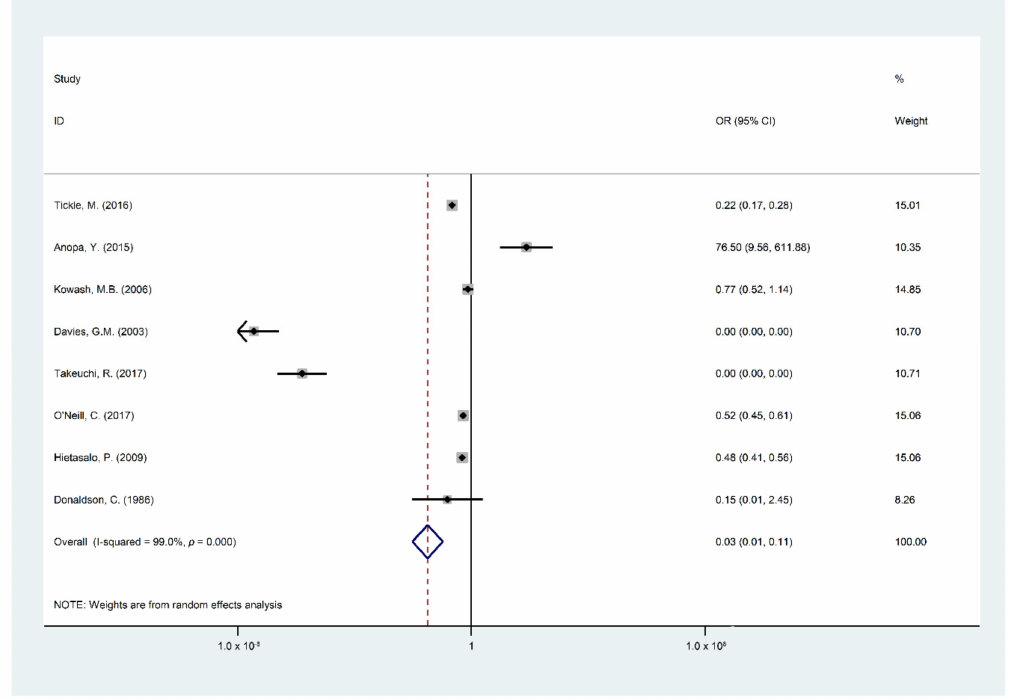
Figure 3. Forest plot of incremental cost-e ff ectiveness per DMFT /